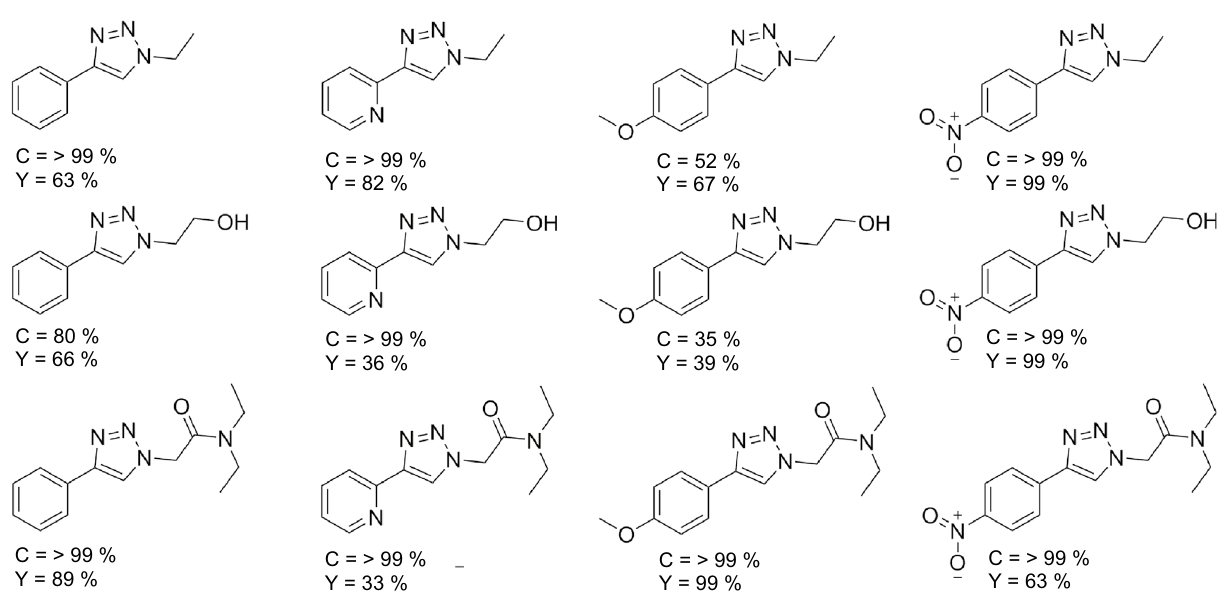
Figure 7. 1,4-disubstituted 1,2,3-triazoles compounds synthesised using the first noted case of an ultrasonically 3D printed flow reactor. Conversions (C) were determined via HPLC analysis, whilst yields (Y) was determined via isolated yield